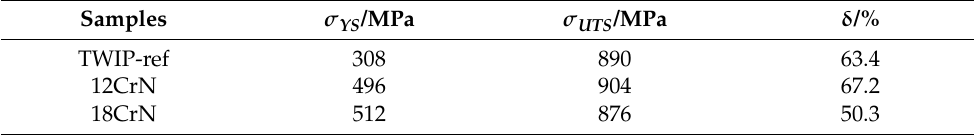
Table 2. Tensile properties of Fe–Mn–Cr–CN steel in comparison to TWIP-ref